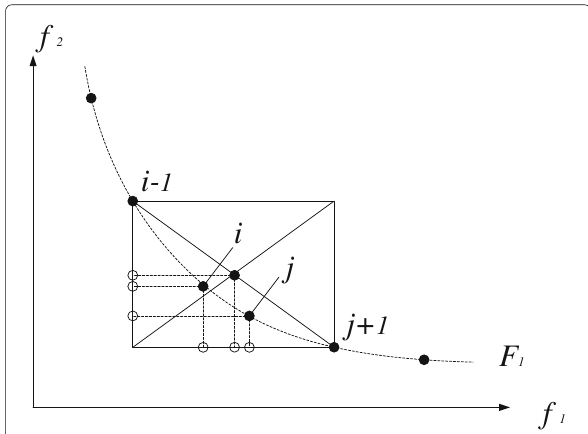
Fig. 6 Removing strategy for adjacent individuals in the same Pareto optimal